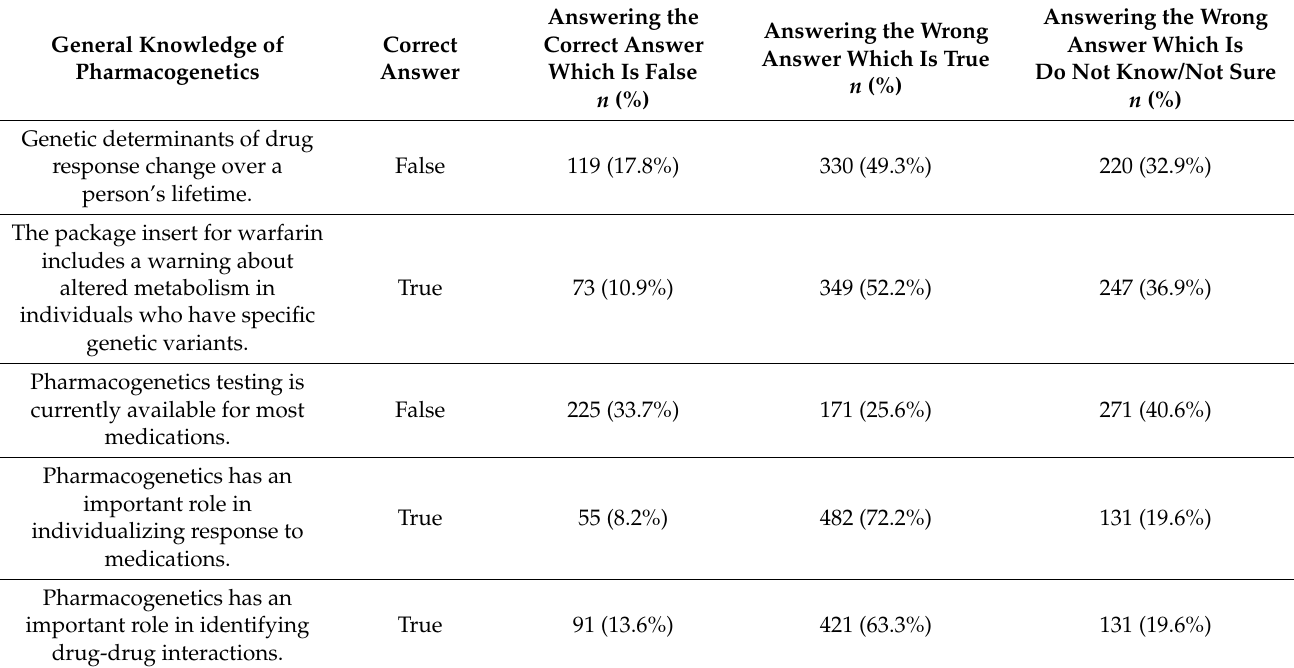
Table 2. Participant’s knowledge on pharmacogenetics.